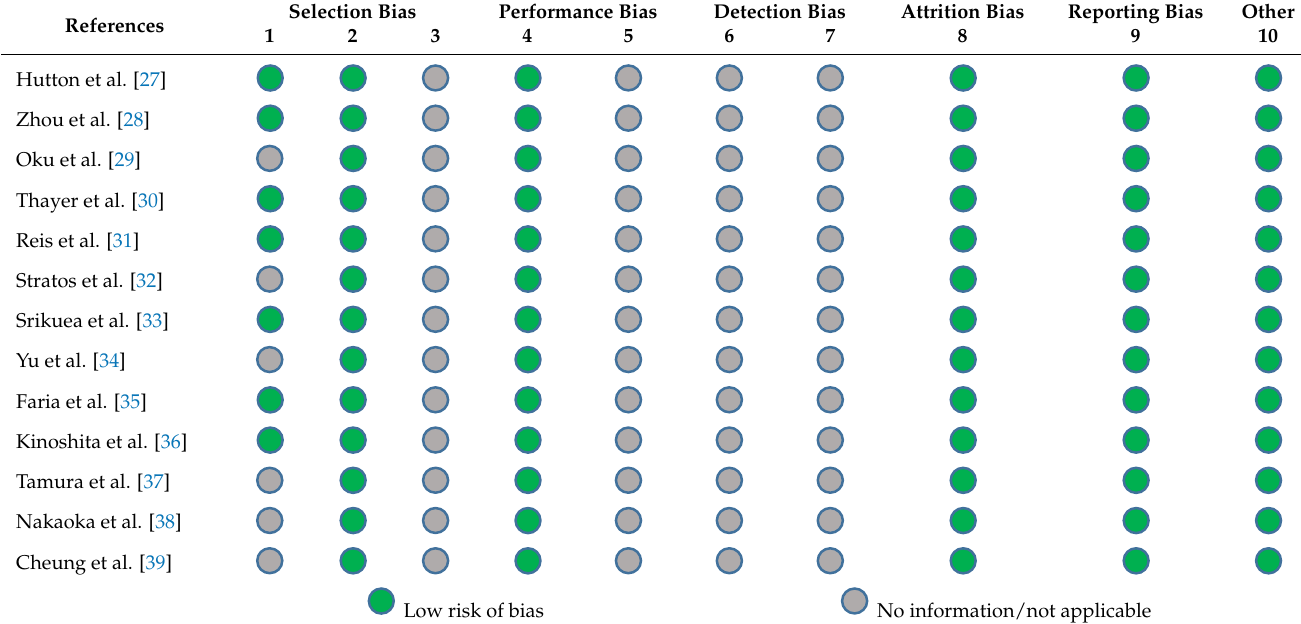
Low risk of bias No information/not applicable